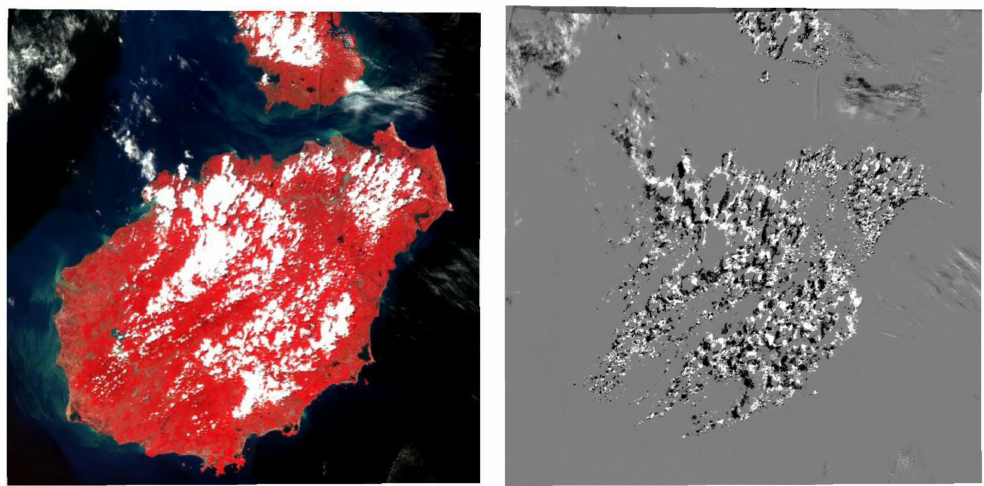
Figure 3. False-color GF-4 image of the Hainan study area with the NIR-R-G composition (left) and a di ff erence map of the time-adjacent images in the same area